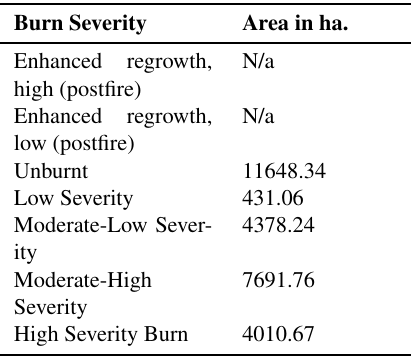
Table 3. Burn severity